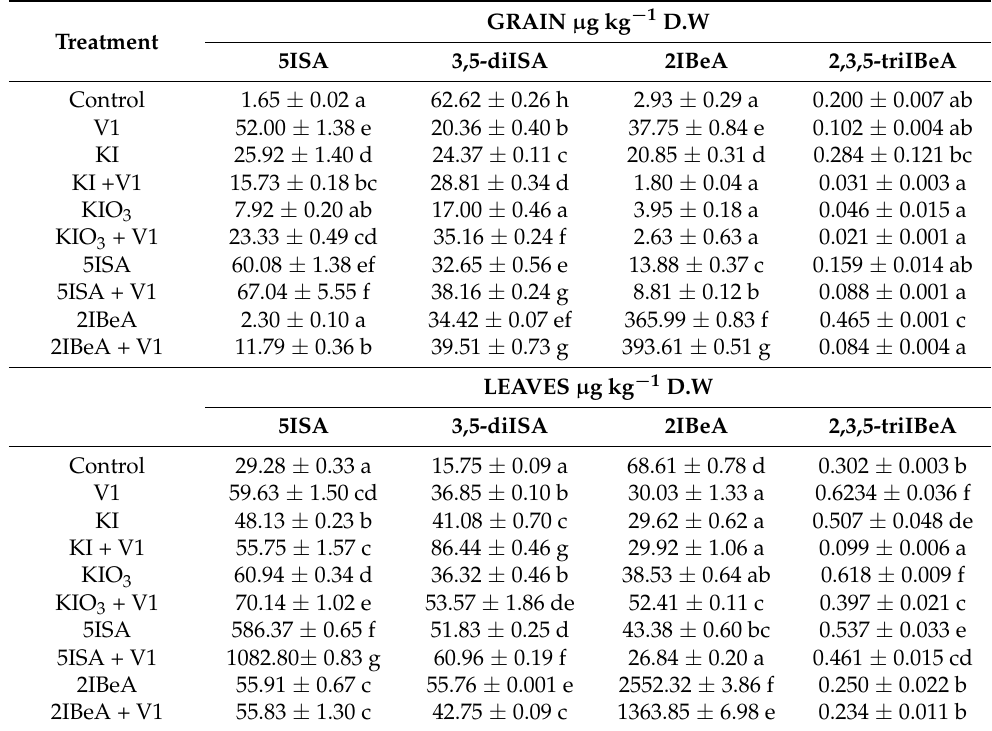
Table 4. Content of iodosalicylates [5-iodosalicylic acid (5ISA) and 3,5-diiodosalicylic acid (3,5- diISA)] and iodobenzoates [2-iodobenzoic acid (2IBeA), 2,3,5-triiodobenzoic acid (2,3,5-triIBeA)]—all in µ g · kg − 1 D.W in sweet corn plants grains and